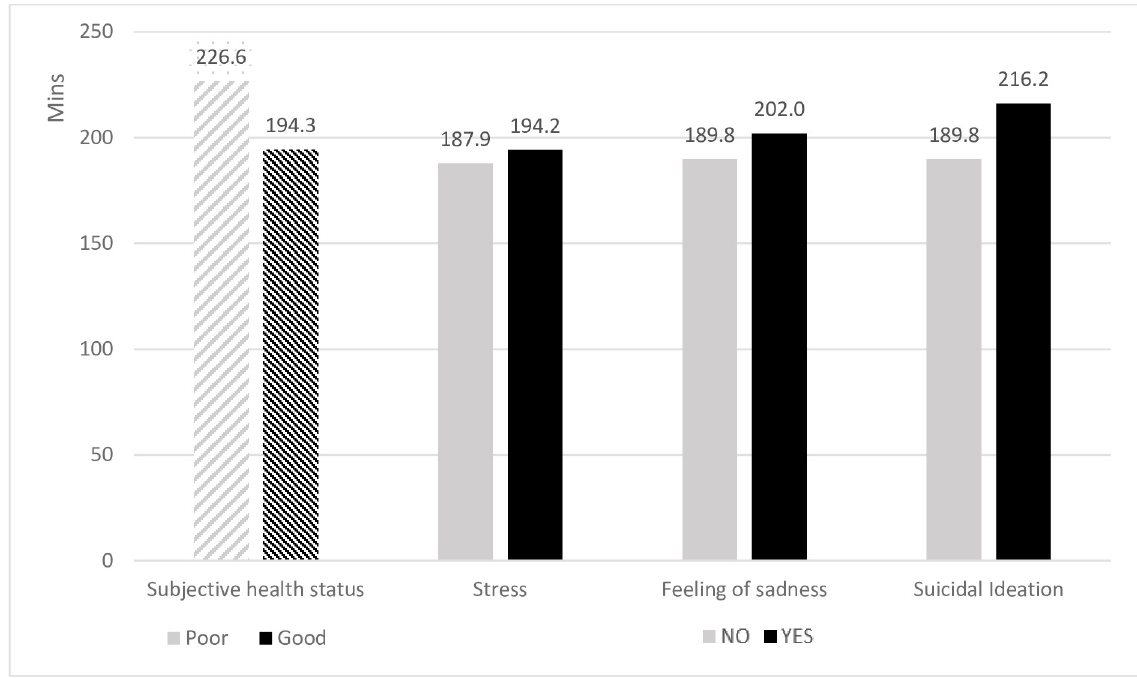
Fig 1. Association between daily Internet usage time, subjective health status, stress, feeling of sadness, and suicidal ideation among adolescents.